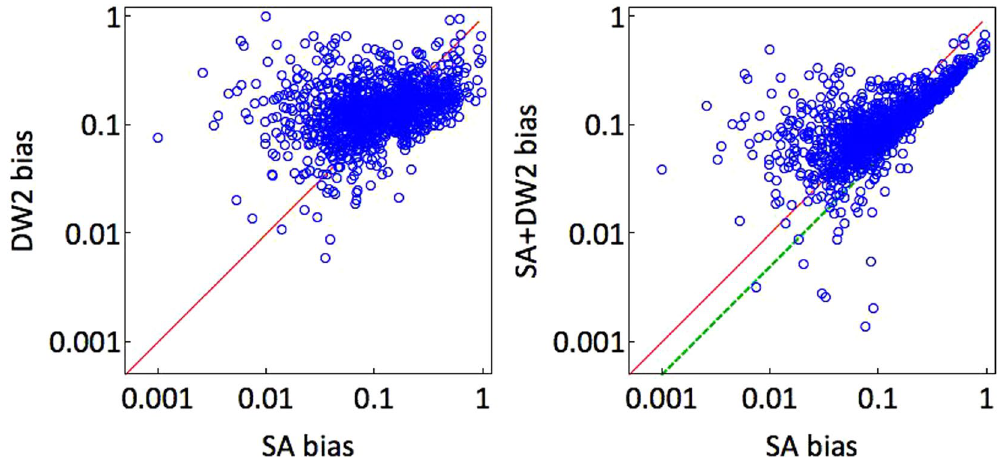
Figure 8. Scatter plots of SA biases vs. DW2 biases and a combination of SA and DW2. Left: The scatter plot indicates that the biases of the DW2 processor are similar in nature to those generated by thermal annealing. Right: Merit of using SA in conjunction with an experimental quantum annealer. Here, results are rather mixed. While for a large portion (over 50%) of the instances a combination of the methods leads to a smaller overall bias, i.e., a lesser degree of unfairness, for the rest of the instances the bias is larger. The solid red line is the ‘equal bias’ y = x line, whereas the dashed green y = x /2 line is the bias obtained via a combination of the horizontal GSD with a flat unbiased